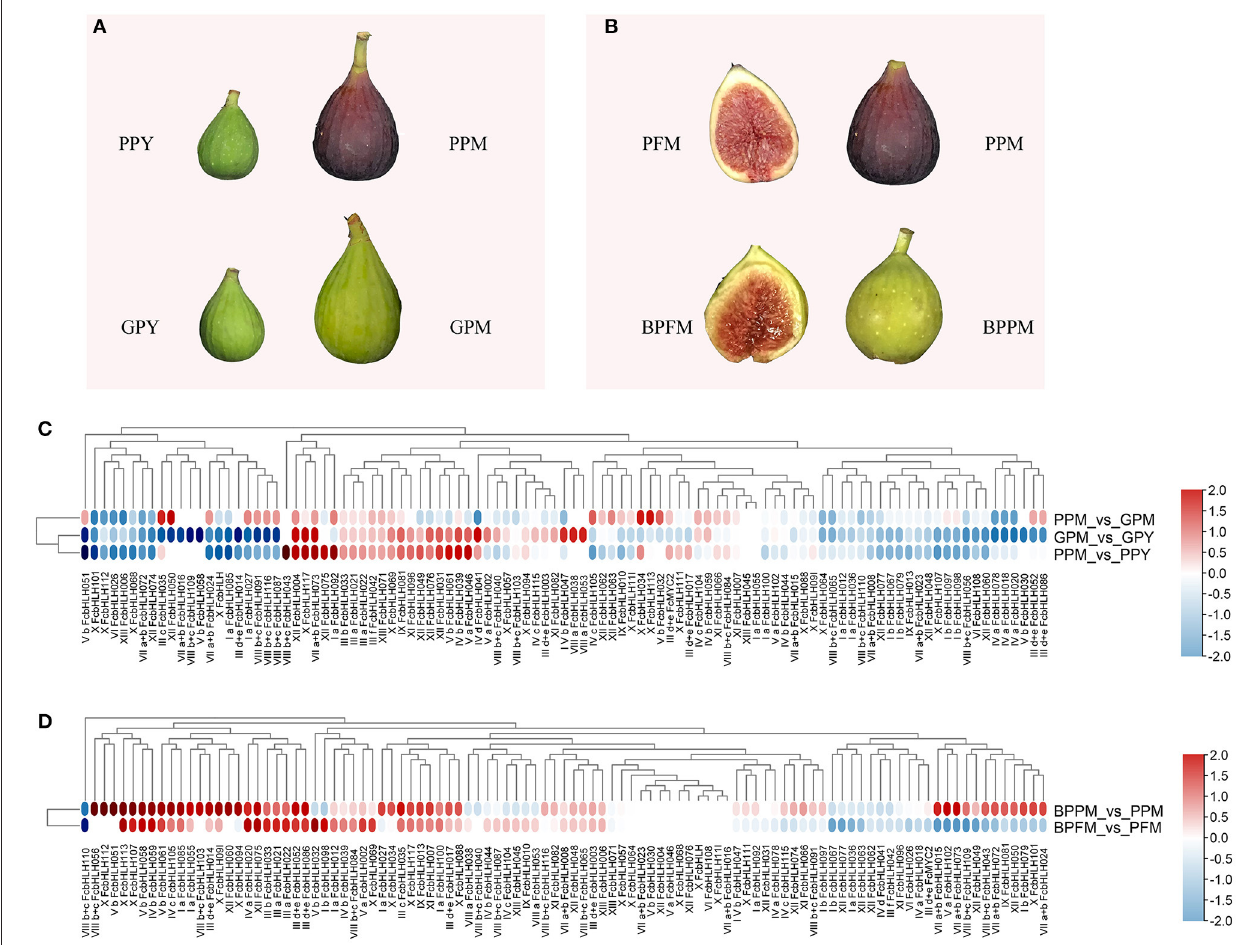
FIGURE 4 | Expression profiles of FcbHLH genes in different fig cultivars and under fruit-bagging treatment conditions. Log 2 FC > 0 indicates upregulation, and log 2 FC < 0 indicates downregulation. PPY and GPY represent the young-stage fruit peel of “Purple-Peel” and “Green Peel” cultivars, respectively; PPM and GPM represent the ripening-stage fruit peel of “Purple-Peel” and “Green Peel,” respectively; PFM represents the ripening-stage female flower of “Purple-Peel”; BPFM and BPPM represent the ripening female flower and peel of “Purple-Peel” fruit, respectively, after bagging. (A) peel color of two fig cultivars. (B) the effect of fruit bagging on female flower and peel color. (C) expression comparison of FcbHLH genes. (D) , the effect of fruit bagging on the expression of FcbHLH